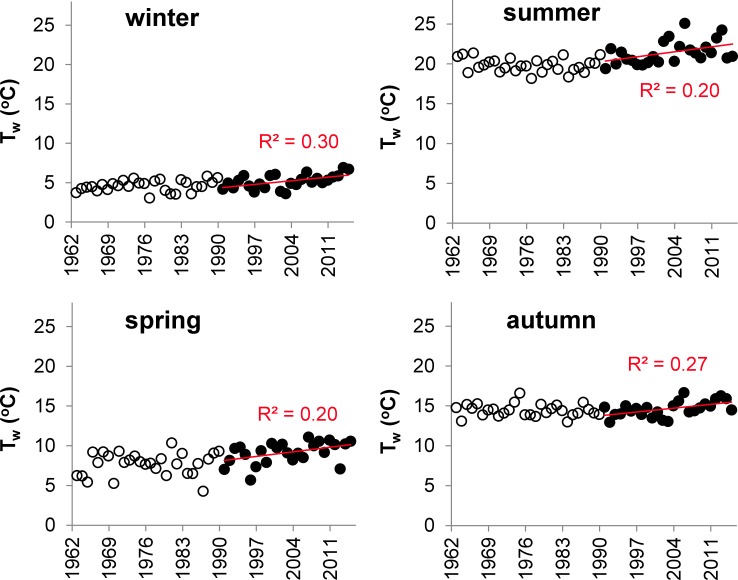
Long-term trends in the seasonal average water temperature (Tw) in the Slapy Reservoir.Open and black points correspond to the years 1963–1990 and 1991–2015, respectively; regression lines indicate significant linear trends (p < 0.05) during 1991–2015.